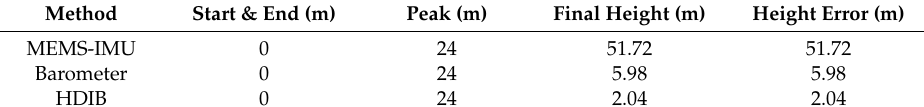
Table 2. Height estimation result of MEMS-IMU, Barometer and HDIB.